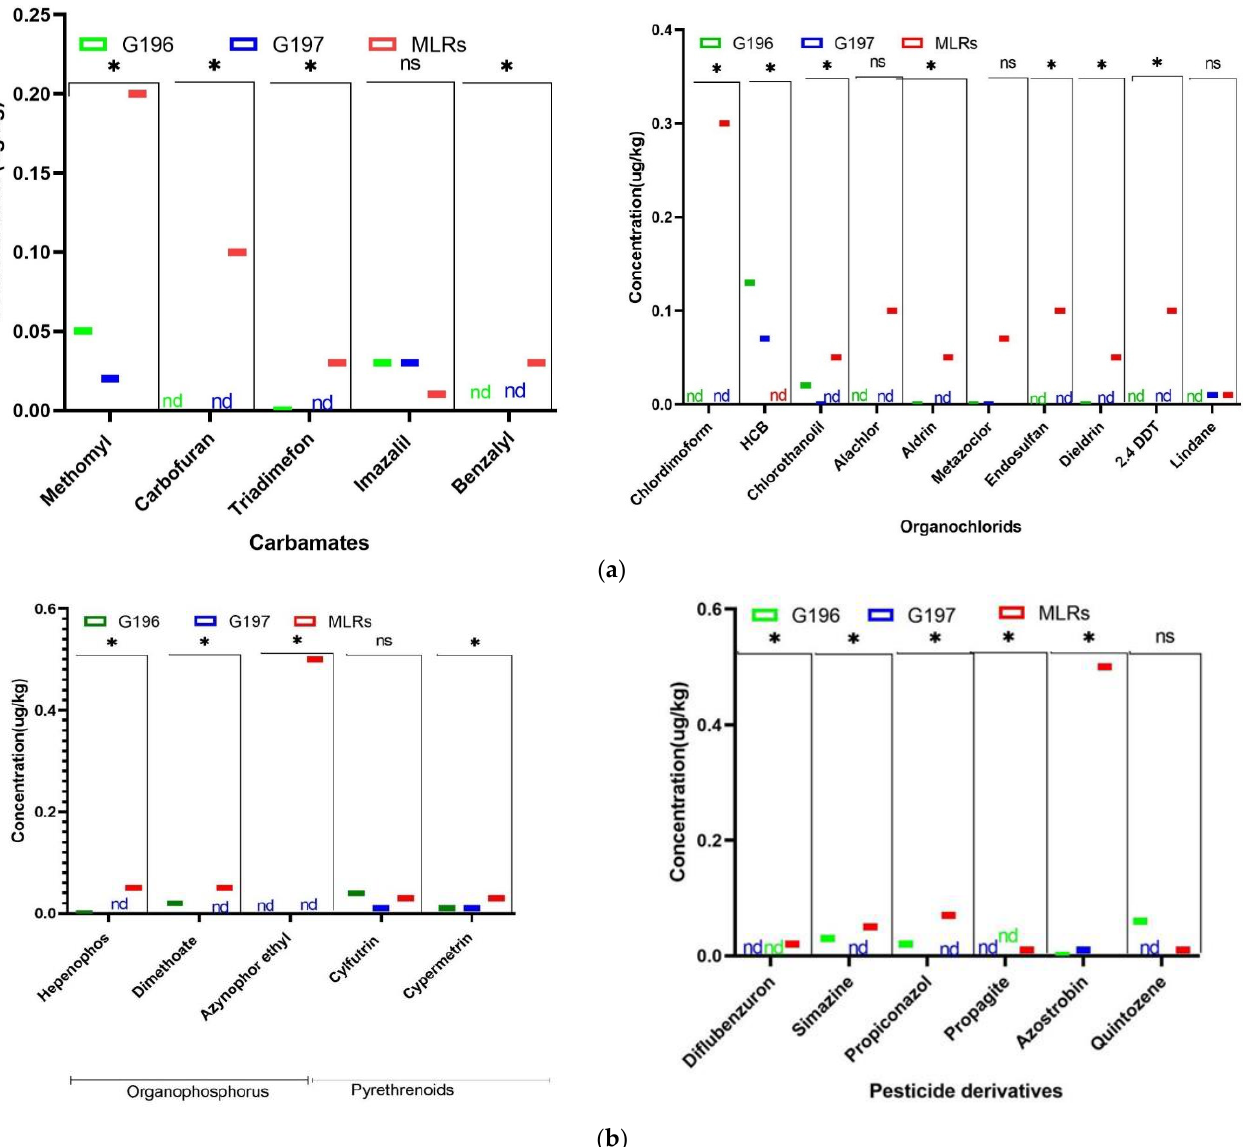
Figure 1. Comparison of pesticide levels in soybean against MRLs ( a , b ). Values are represented as mean ± SEM; “ * ” indicates a significant difference for each line ( p < 0.05); “ns” indicates a significant difference for each line ( p < 0.05).